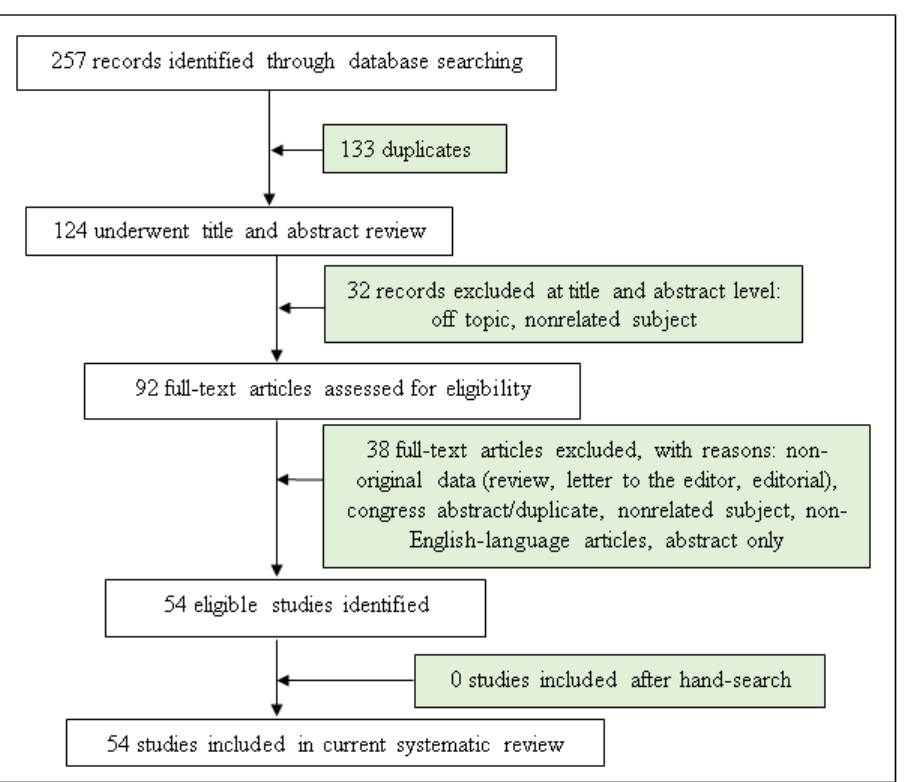
Figure 1. Flow chart of study selection.